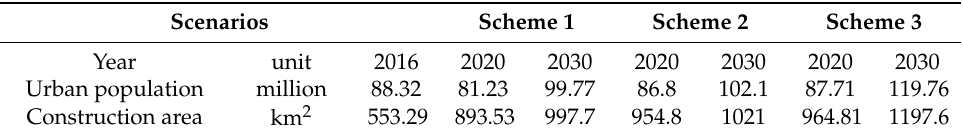
Table 4. The optimal thresholds of urbanization scale of Xi’an in Schemes